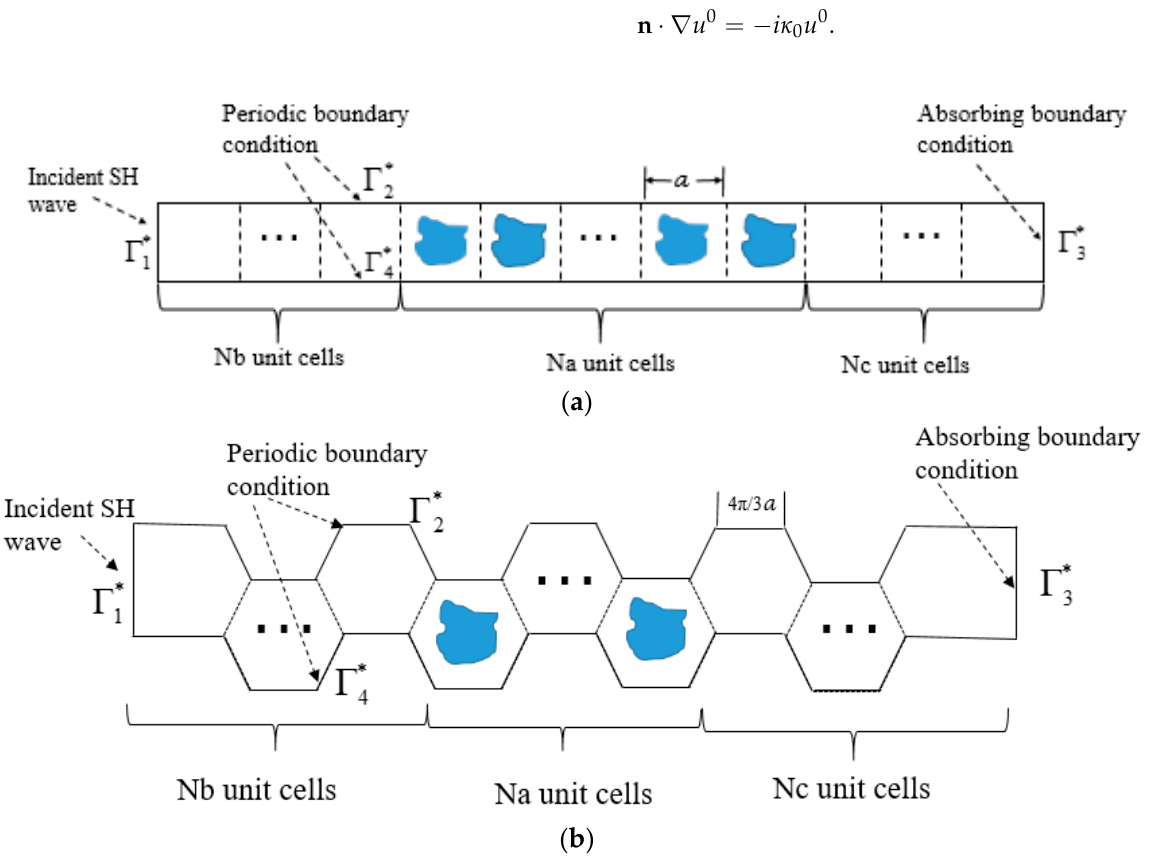
Figure 2. A perfectly phononic crystal with semi-infinite periodic structure of ( a ) square lattices and ( b ) triangular lattices with the related boundary conditions.